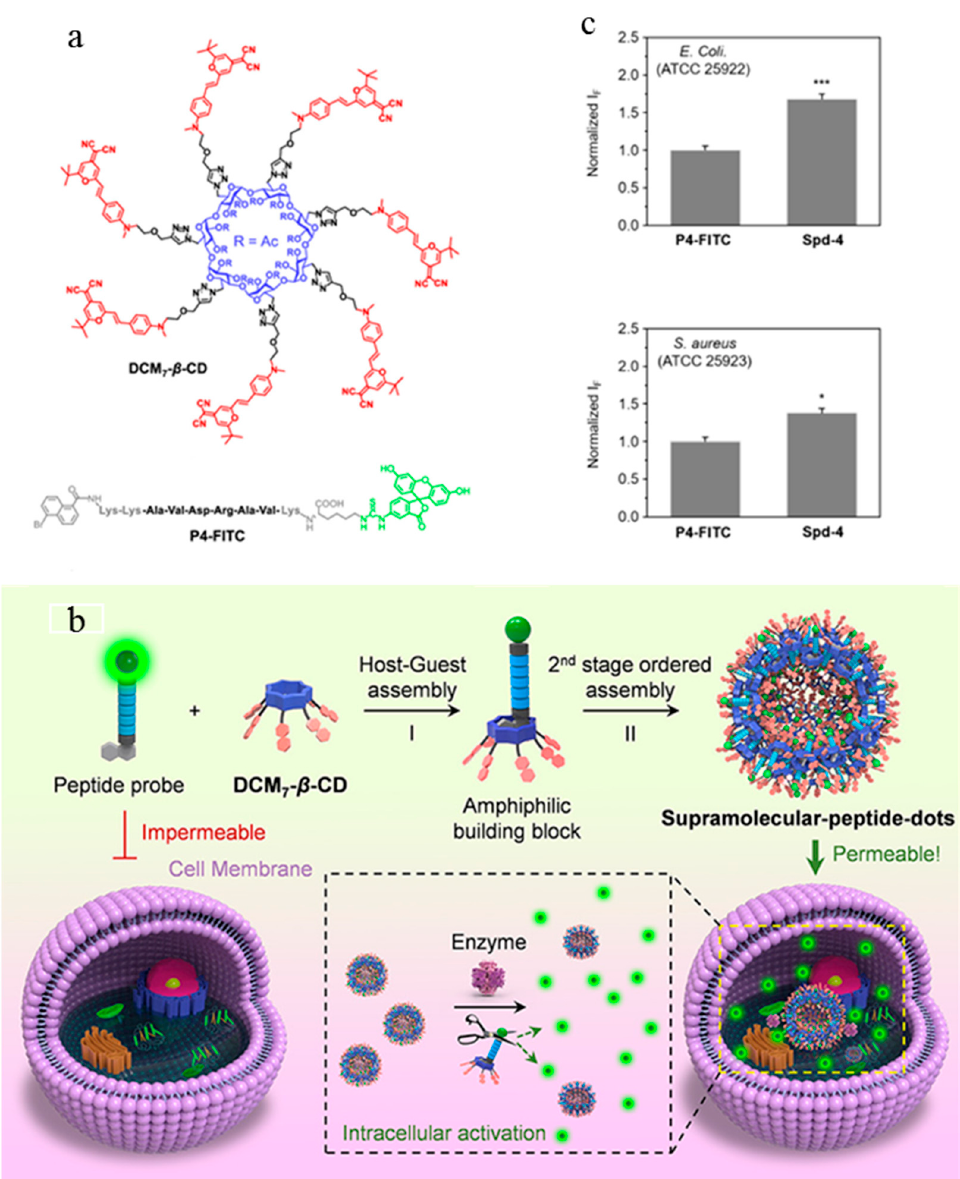
Figure 14. ( a ) Structure of the DCM 7 - β -CD and fluorescent antimicrobial (P4-FITC) peptide. ( b ) Sche- matic illustration of the sequential host–guest and second-stage ordered self-assembly between probes and DCM 7 - β -CD to provide so-called Spds with enhanced cellular uptake and functional imaging features. The fluorescent green dots indicate individual FITC moieties. ( c ) Fluorescence quantification of E. Coli . and S. aureus treated with P4-FITC (1 μ M) or Spd-4 (P4-FITC/ DCM 7 - β -CD = 1 μ M/1 μ M). * p < 0.05, *** p < 0.001. Reproduced with permission from Ref. [82]. Copyright 2020, American Chemical